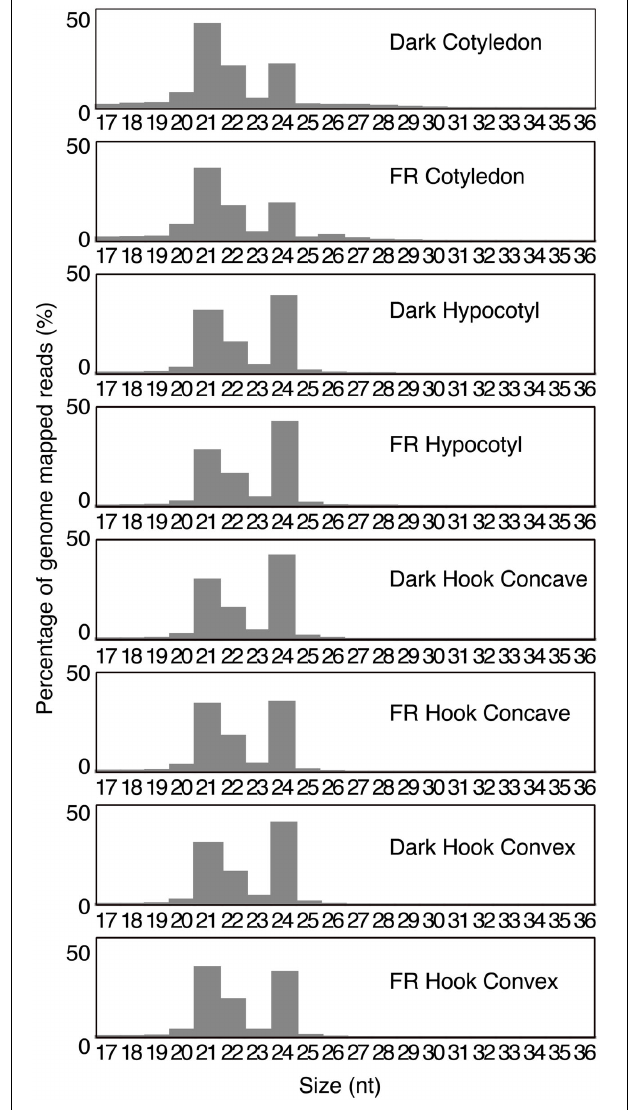
FIGURE 3 | Abundance of size classes of small RNA (17–36nt). The percentages of the abundance of genome-mapped small RNA of each size class are plotted for each